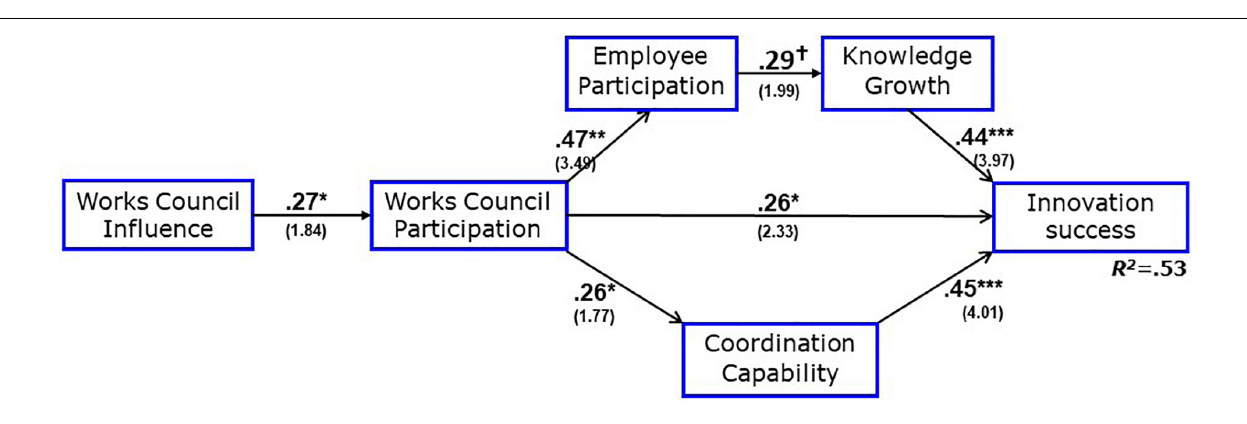
Figure 3 to Figure 4 . Coordination capability, in turn, is